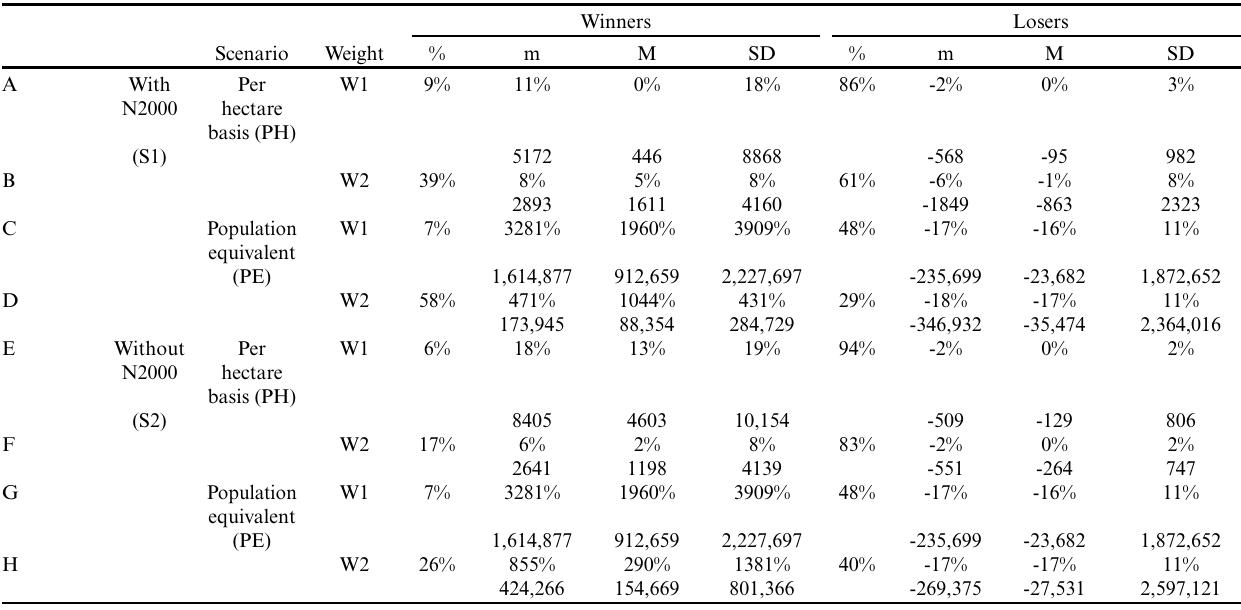
Table 3 . Overview of the results for all scenarios of green fiscal transfers. m = mean, M = median, and SD = standard deviation, absolute numbers in euros. N2000 = Natura